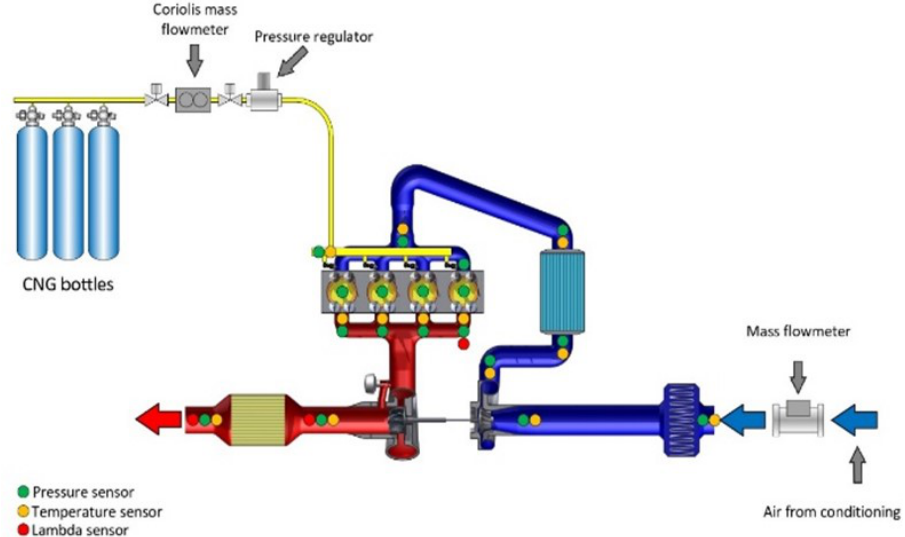
Figure 3. Sensor placement